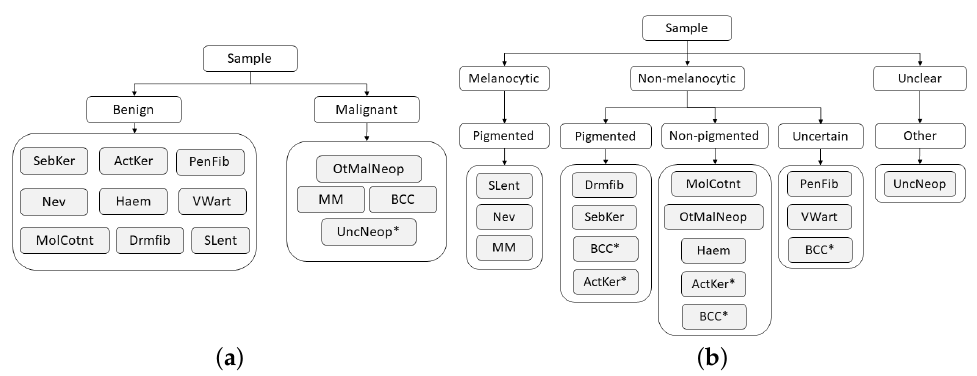
Figure 4. Hierarchies considered for skin lesion diagnosis. ( a ) Two-level hierarchy. ( b ) Three- level